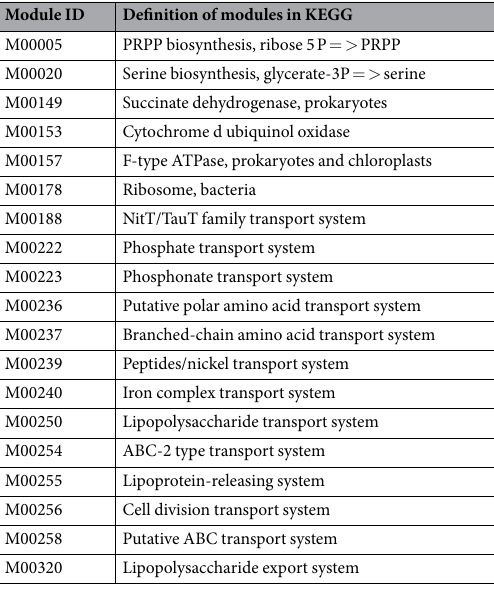
Table 4. Core modules shared between habitats as detected by HUMAnN2.